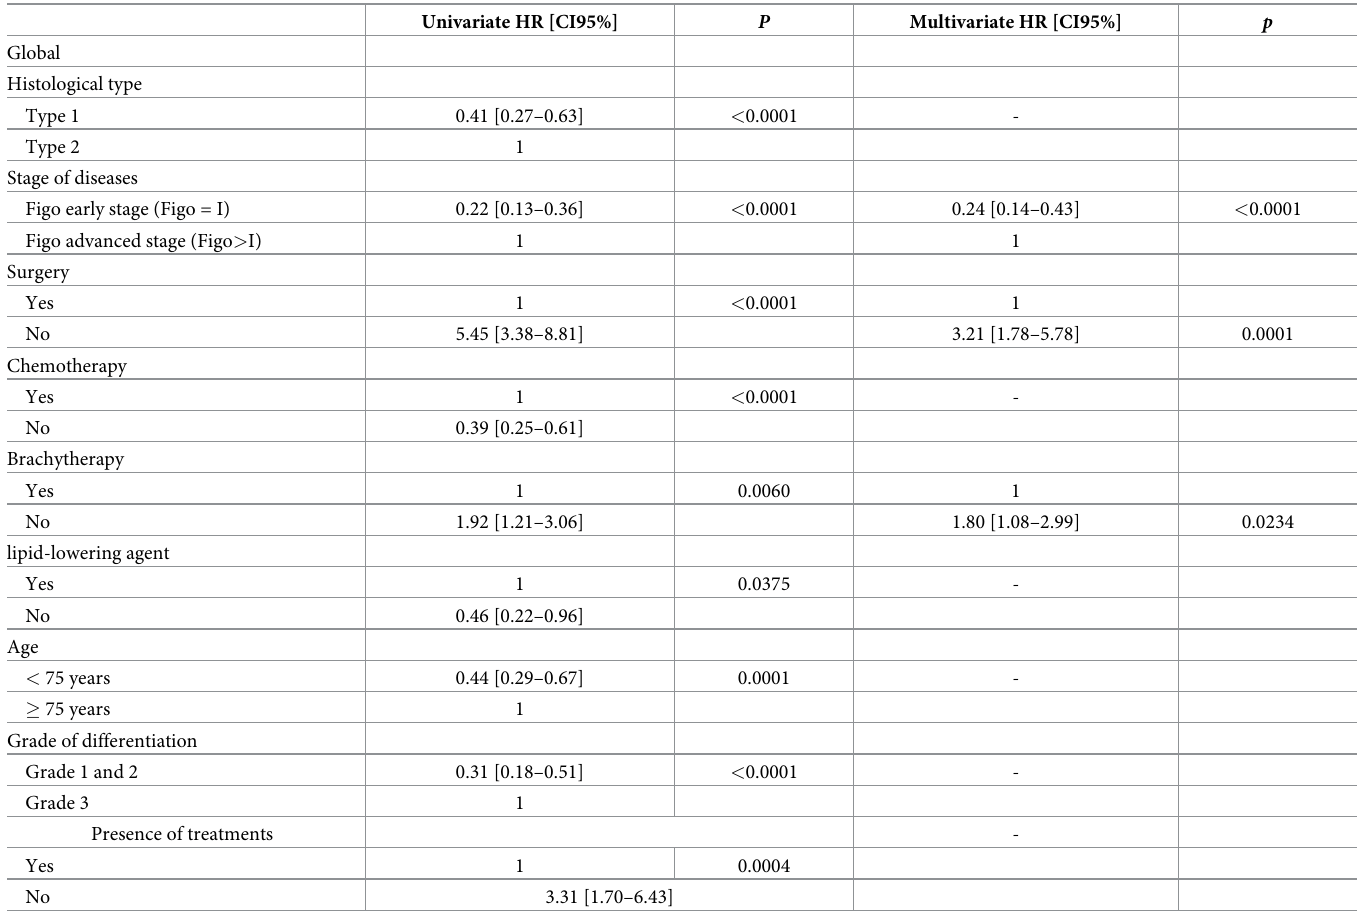
Table 3. Prognostic factors of endometrial cancer survival in Martinique, 2012–2016 (N =